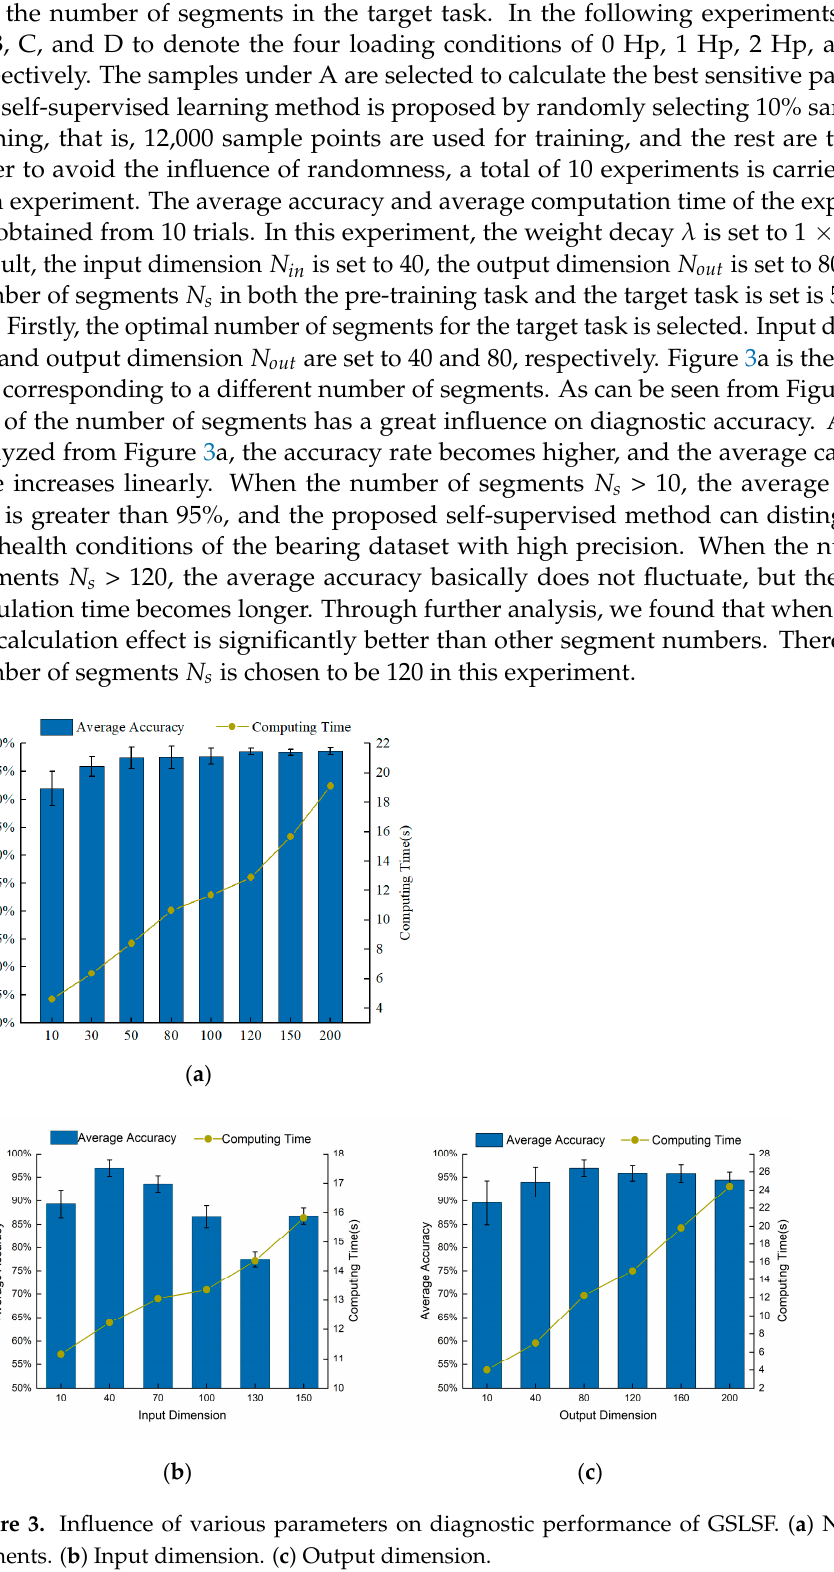
N = 50. Figure 3b s